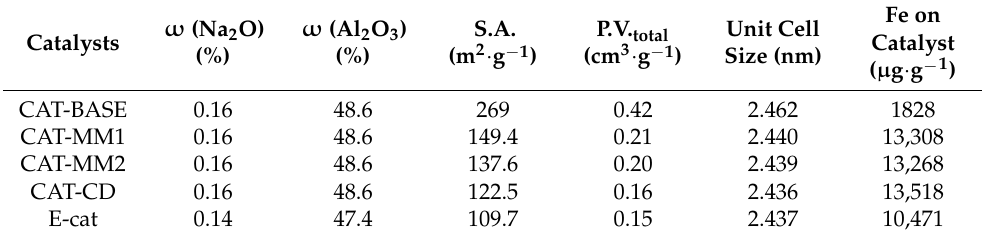
Table 1. Properties of different catalysts.